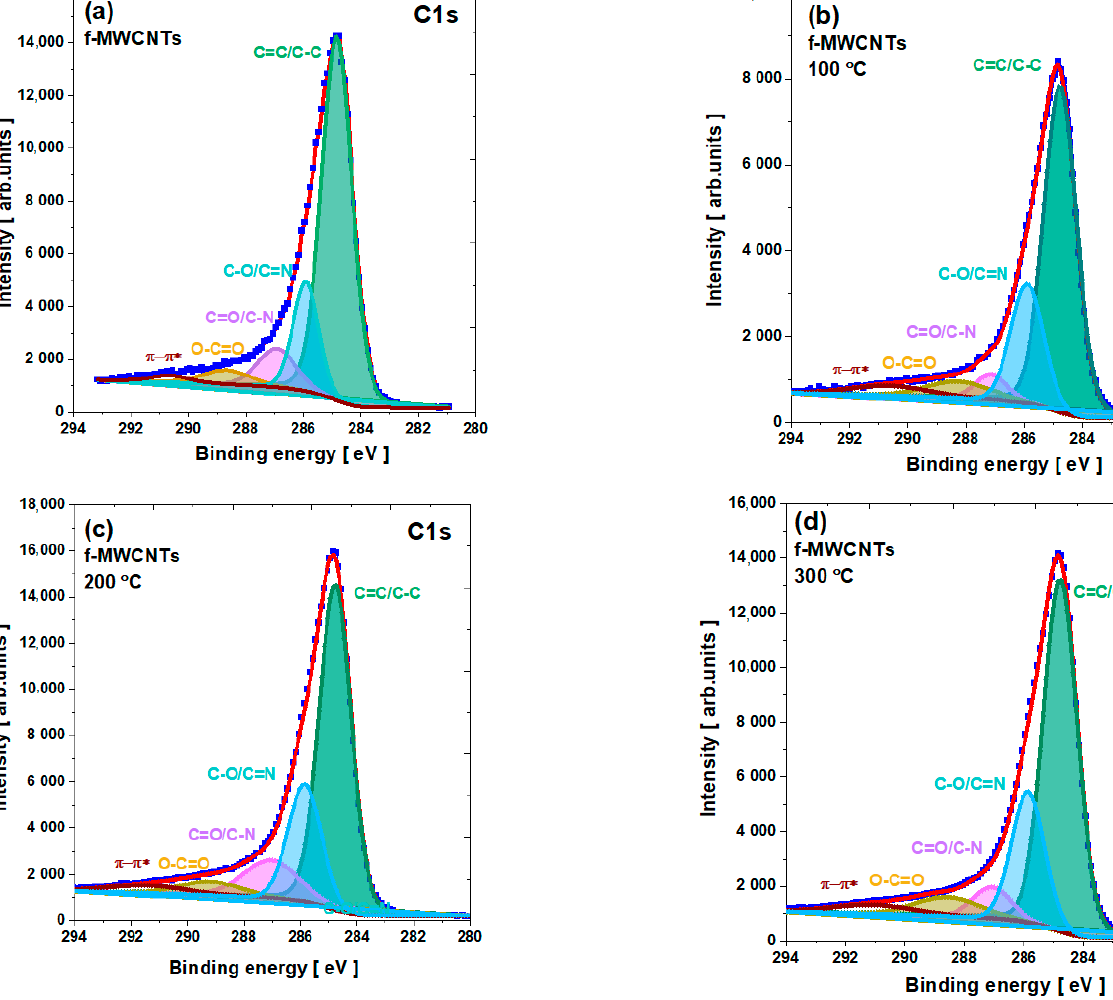
Figure 5. The C1s core level line for f-MWCNTs: ( a ) pristine; calcined at ( b ) 100 °C; ( c ) 200 °C; and ( d ) 300 °C.